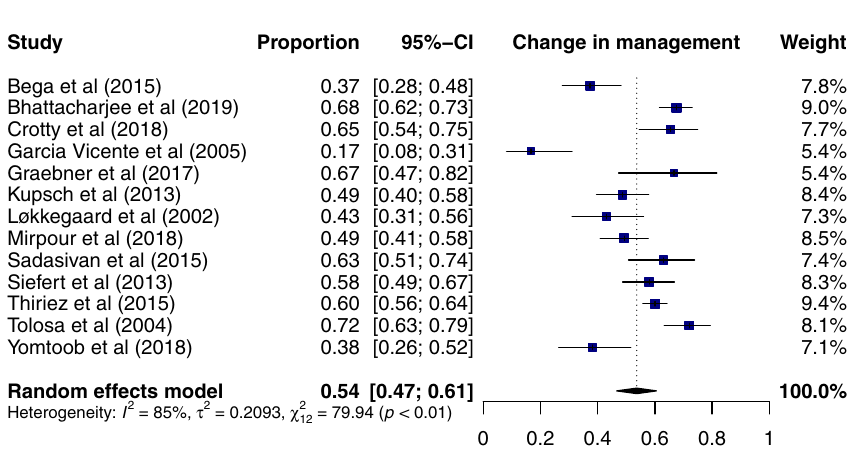
Fig. 1 Forest plot of the meta-analysis of studies reporting change in management with DaTscan using a random-effects model. The studies are ordered